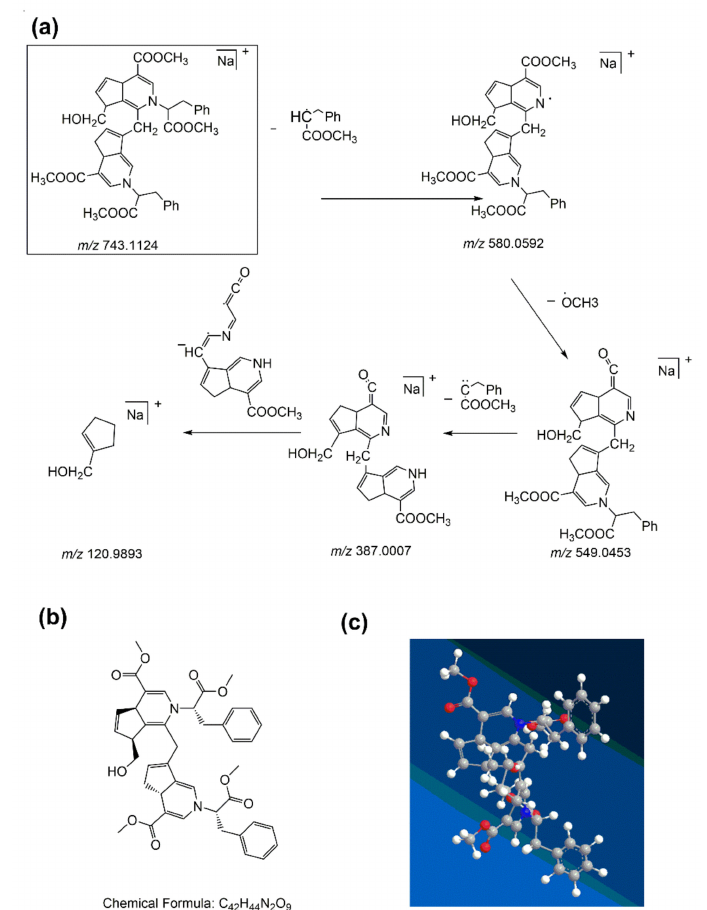
Figure 7. The fragmentation pathway of water-insoluble gardenia blue pigment Z-2 ( a ). The planar and 3D molecular structure simulation graphs of the pigment Z-2 ( b ) and ( c ) (C-ray, O-red, N-blue,